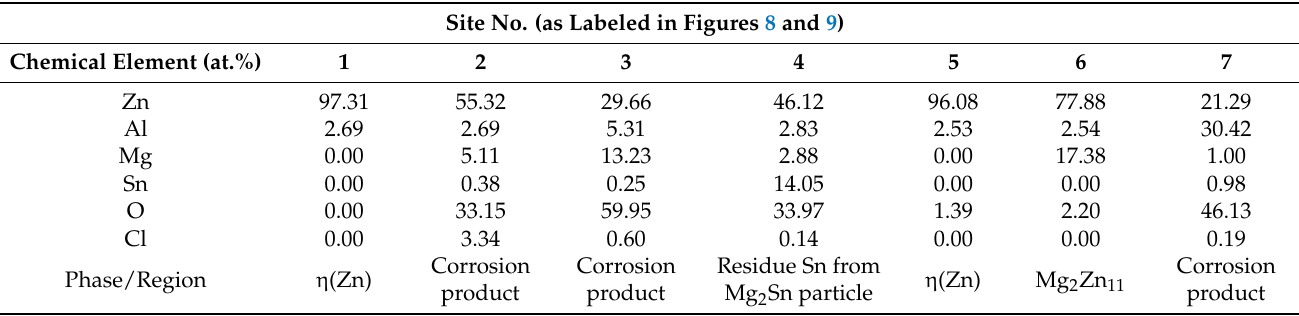
Figure 10. XRD patterns of corrosion product powders retrieved from the as-cast samples after 1000 h of NSST: ( a ) pure Zn ( b ) MZ+0.0Sn ( c ) MZ+0.5Sn ( d ) MZ+3.0Sn.